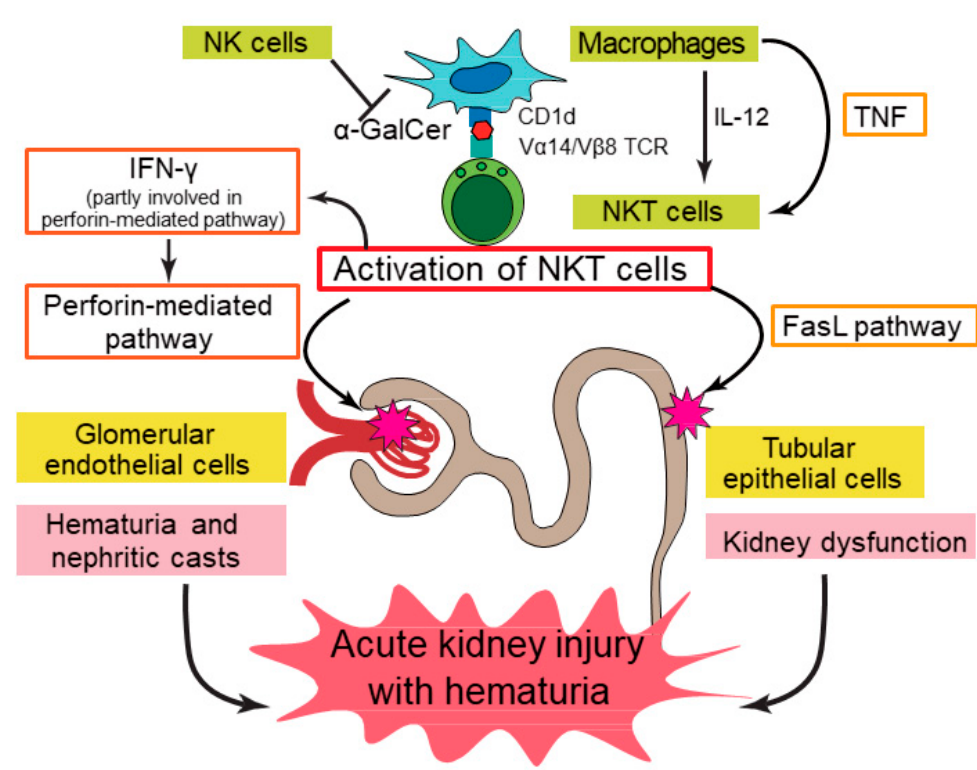
Figure 1. Putative pathogenic mechanisms underlying kidney injury induced by alpha-galactosylceramide ( α -GalCer)-stimulated natural killer T (NKT) cells in mice. Activated NKT cells cause hematuria and nephritic casts by damaging glomerular endothelial cells in a perforin-dependent manner, whereas they damage tubular epithelial cells via Fas ligand (FasL) pathway activation, which leads to kidney dysfunction. IFN- γ produced by activated NKT cells is partly involved in perforin pathway activation, and TNF- α produced by macrophages is mainly involved in activation of the FasL pathway. Both pathways exert independent effects, thereby inducing acute kidney injury with hematuria. IL-12 enhances α -GalCer-activated functions of NKT cells, whereas NK cells may play a protective role in this model. This scheme is based on the figure from Uchida et al. [14].